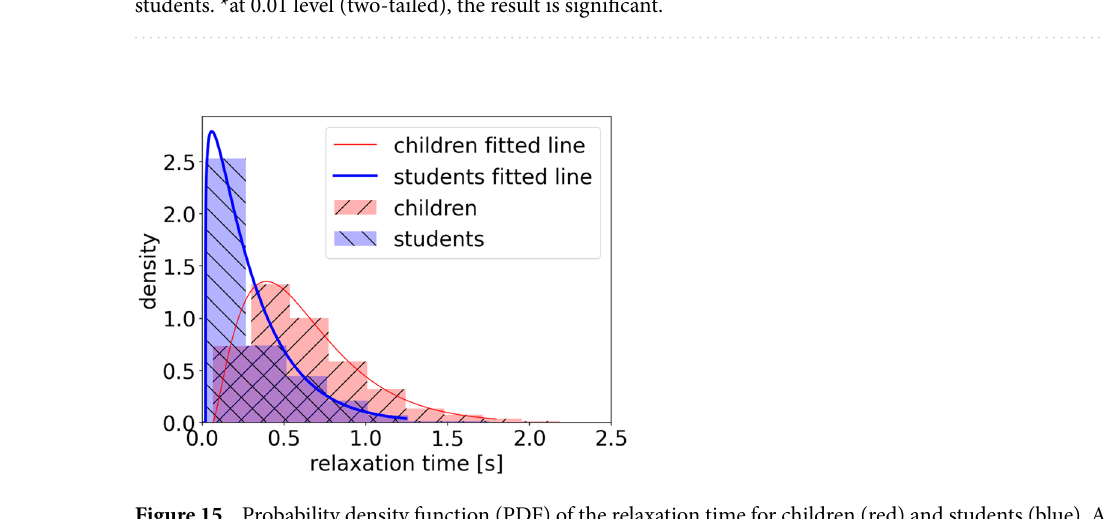
Figure 15. Probability density function (PDF) of the relaxation time for children (red) and students (blue). An Erlang distribution fits the data well.